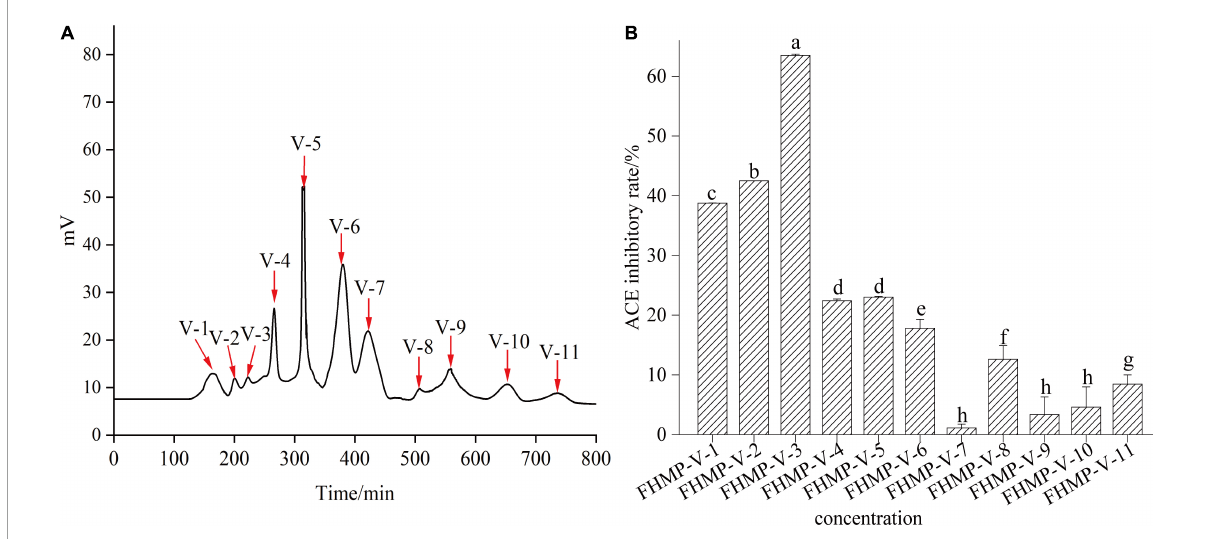
FIGURE5 The curve of FHMP-V gel chromatography (A) and the ACE inhibitory activity of 11 mixed components (V-1 to V-11) (B) . Means denoted by a different letter indicate significant differences between treatments ( P <